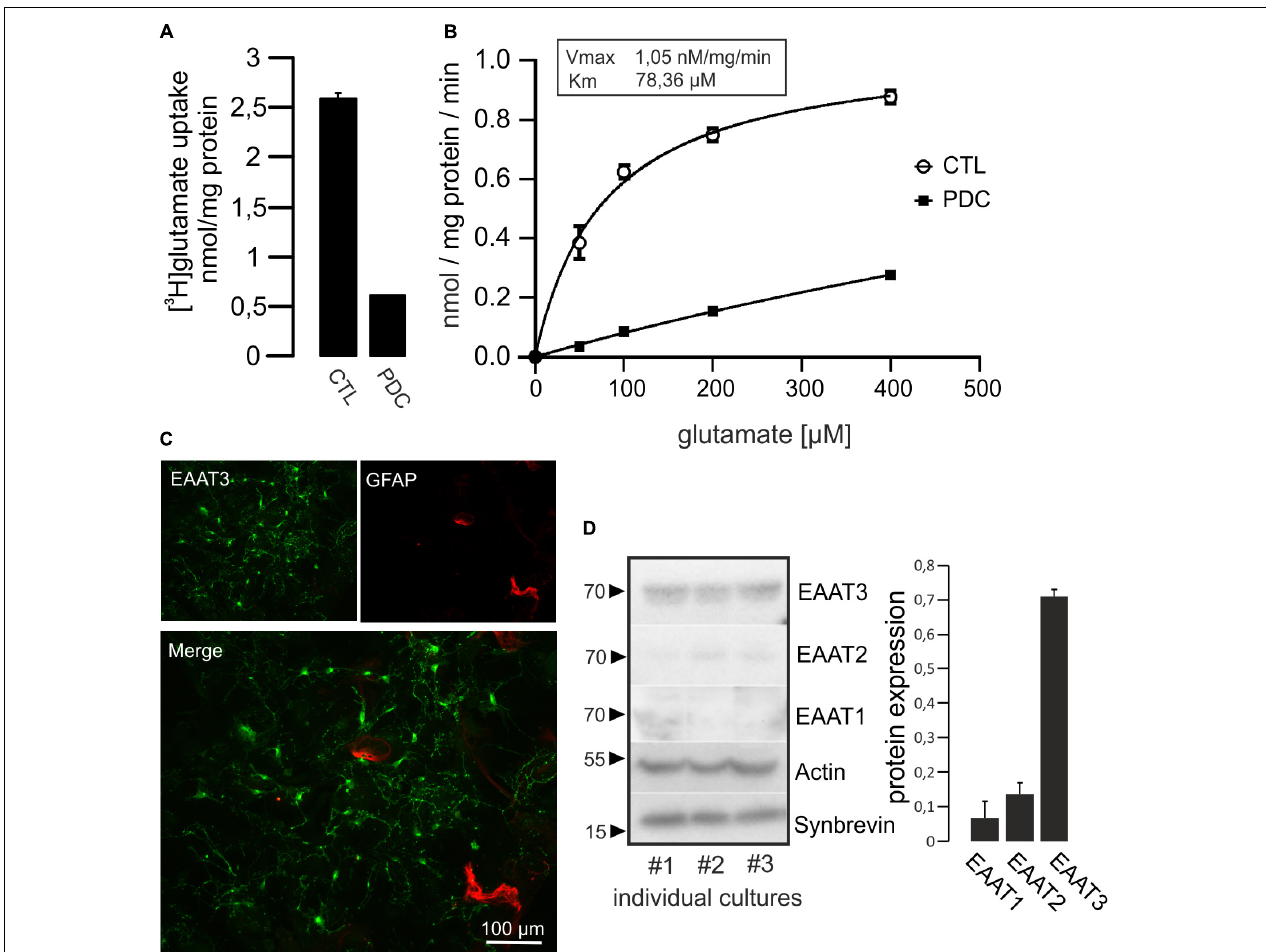
FIGURE 2 | Hippocampal neurons take up [ 3 H]glutamate in a specific manner. (A) Cultured hippocampal neurons were grown in 24-multiwell dishes for 14 days and incubated for 1 h with radiolabeled glutamate (50 µ M). After removal of medium, cells were washed intensively, lysed and radioactivity taken up was calculated by liquid scintillation counting. Values were adjusted to protein content. Specific uptake was evaluated by the addition of 1 mM of the glutamate uptake inhibitor L- trans- pyrrolidine-2,4-dicarboxylate (PDC). Uptake of [ 3 H]glutamate was strongly inhibited by PDC and therefore regarded as specific. (B) Kinetic analysis of glutamate uptake (uptake time 10 min) revealed saturable concentration-dependent transport kinetics (V max and K m values are indicated). Values in (A,B) are expressed as means ± SEM from triplicate samples within a single representative experiment repeated two times. (C) Neurons were grown on glass cover slips for 14 days, fixed and stained for EAAT3 and GFAP as marker for astrocytes. Staining against EAAT3 and GFAP revealed that the vast majority of cells represented neurons at that culture time. (D) Homogenates of cultured hippocampal neurons were subjected to Western blot procedure and probed for the expression of neuronal EAAT3, as well as glial EAAT2 and EAAT1. Actin was used as loading control, Synaptobrevin was used as synaptic neuronal marker. Quantification from three individual cultures revealed that EAAT3 represented the predominant glutamate transporter. Values in (D) are expressed as means ± SEM adjusted to Actin from three individual